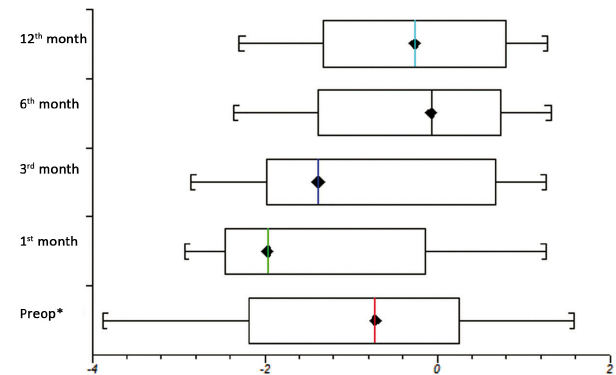
Fig. 3 - Evolution of z-scores for height/age (HAZ) in the group of cardiac patients. Analysis of variance with P=0.182. (*) HAZ was significantly lower when compared with the general population’s in the preoperative period